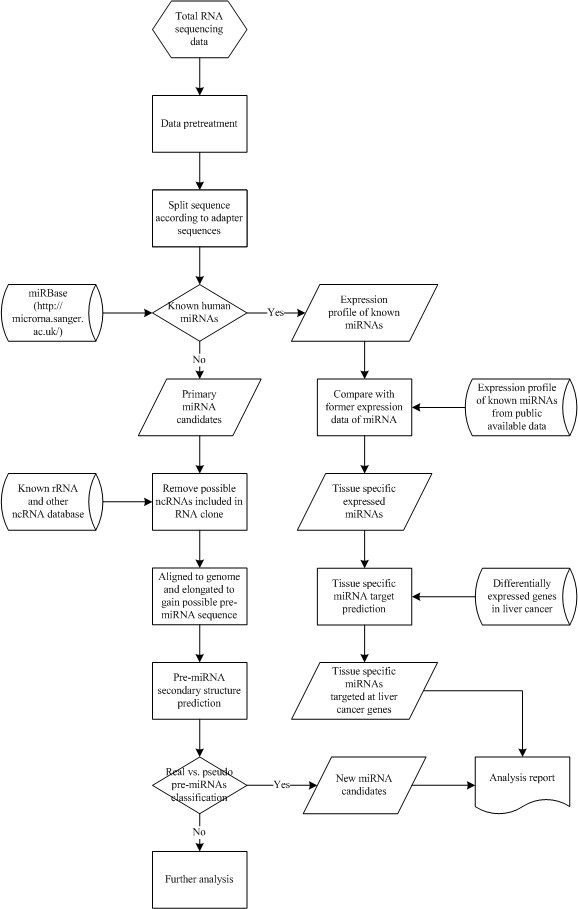
Work flow of miRAS.